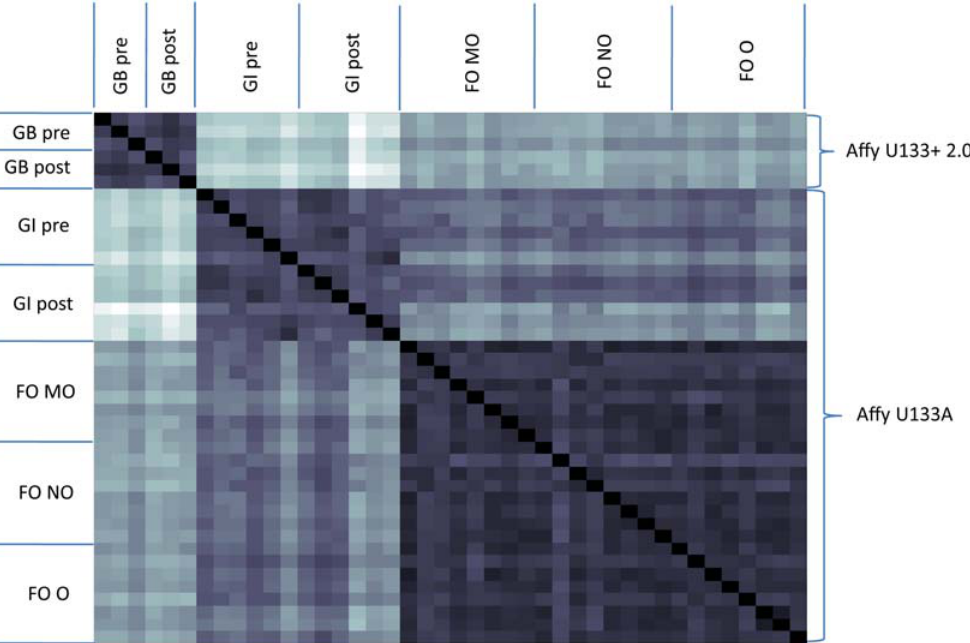
Figure 10. A comparison of skeletal muscle models. This heat map displays the level of difference in each pair of models. Darker squares represent models that are more similar to each other than lighter squares. A black square (as on the diagonal) indicates identical models, and a white square indicates the most different pair of models. The three darker blocks that surround the main diagonal are the comparisons of samples within each dataset to each other. These darker blocks show that the models within each dataset tend to be more similar to each other than to models from other datasets. The models from a particular expression array type also appear to be more similar to each other than to models from a different array types, but the data available do not allow us to show that this is actually true, as is shown in Figure